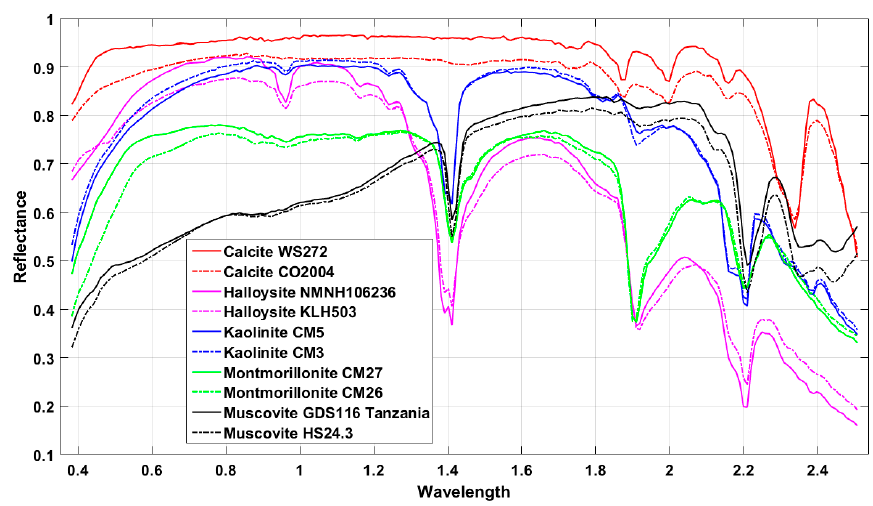
Figure 12. Endmembers used to simulate the last dataset.